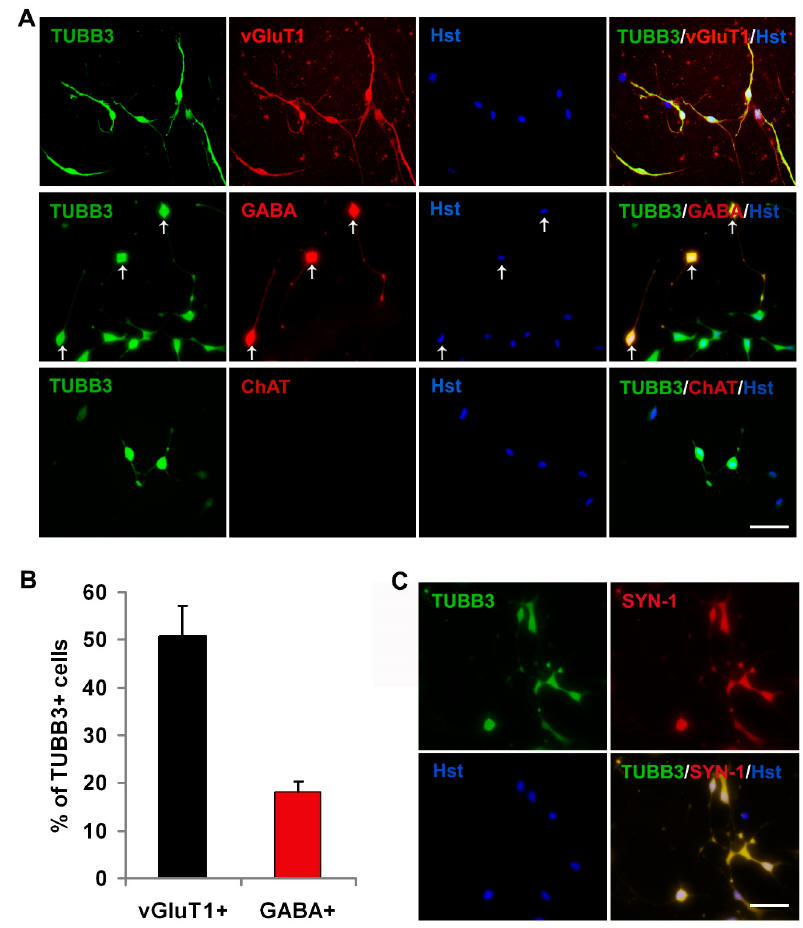
Figure 5. Characterization of glioma cell-derived neurons. ( A ) Cellular identity analysis of ASCL1-induced neurons using specific neuronal markers vGluT1, GABA and ChAT at 21 dpi. ( B ) Quantification of neuronal subtypes (n = 20 random fields from triplicate samples). ( C ) Expression of presynapic markers synapsin-1 (SYN-1) at 21 dpi. Scales: 50 µ m ( A , C